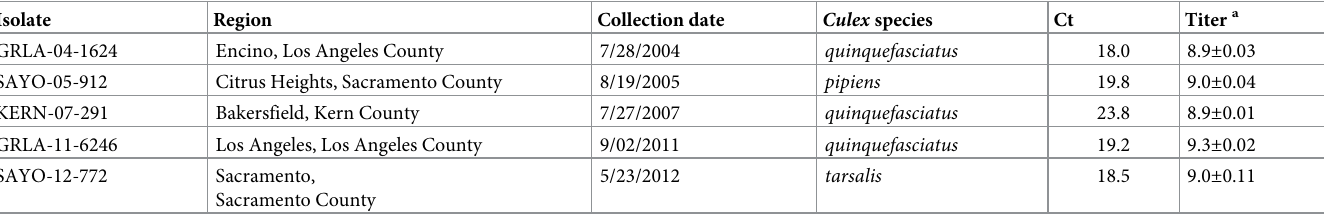
Table 1. Mosquito pools containing WNV collected during 2004–2012 California